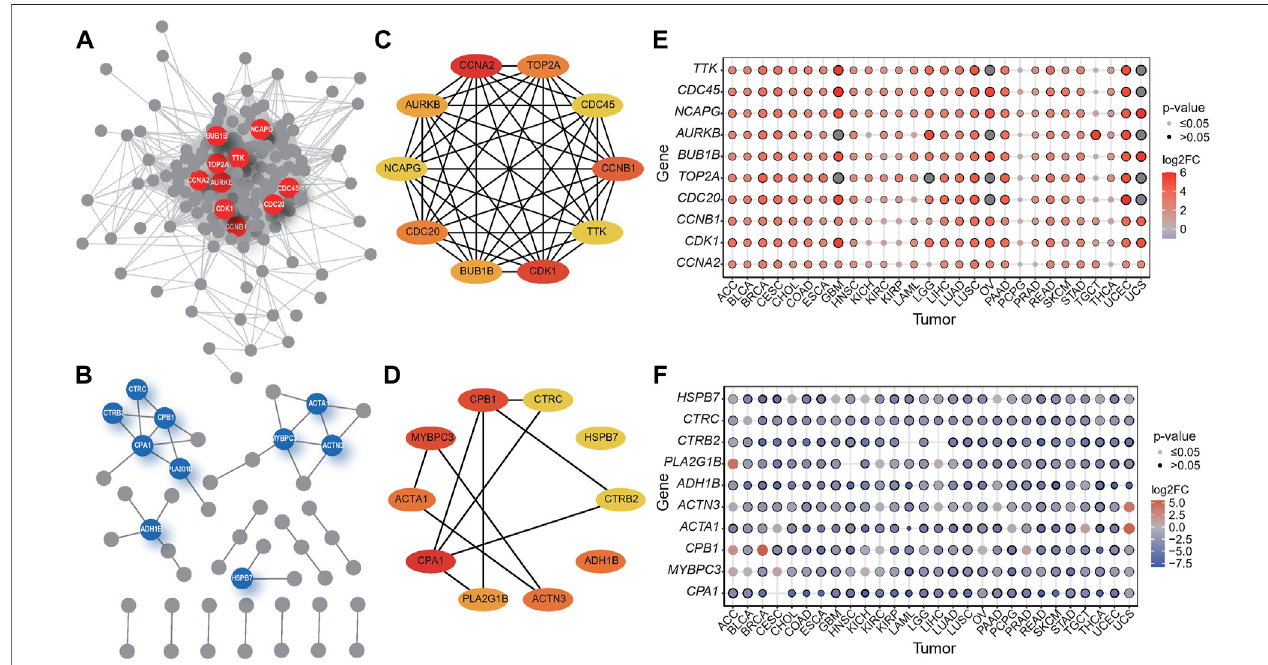
FIGURE3| PPInetworkofthehubgenesintumorsandtheexpressionpro fi leofhubgenes. (A – B) PPInetworksofup-regulated (A) anddown-regulated (B) DEGs shared by 28 tumors. The hubs genes were in the center of the network, represented by colored circles. (C – D) PPI among top 10 identical up- (C) and down-regulated (D) DEGs in various cancers. (E – F) Gene expression of hub genes in identical up- (E) and down-regulated (F) DEGs in 28